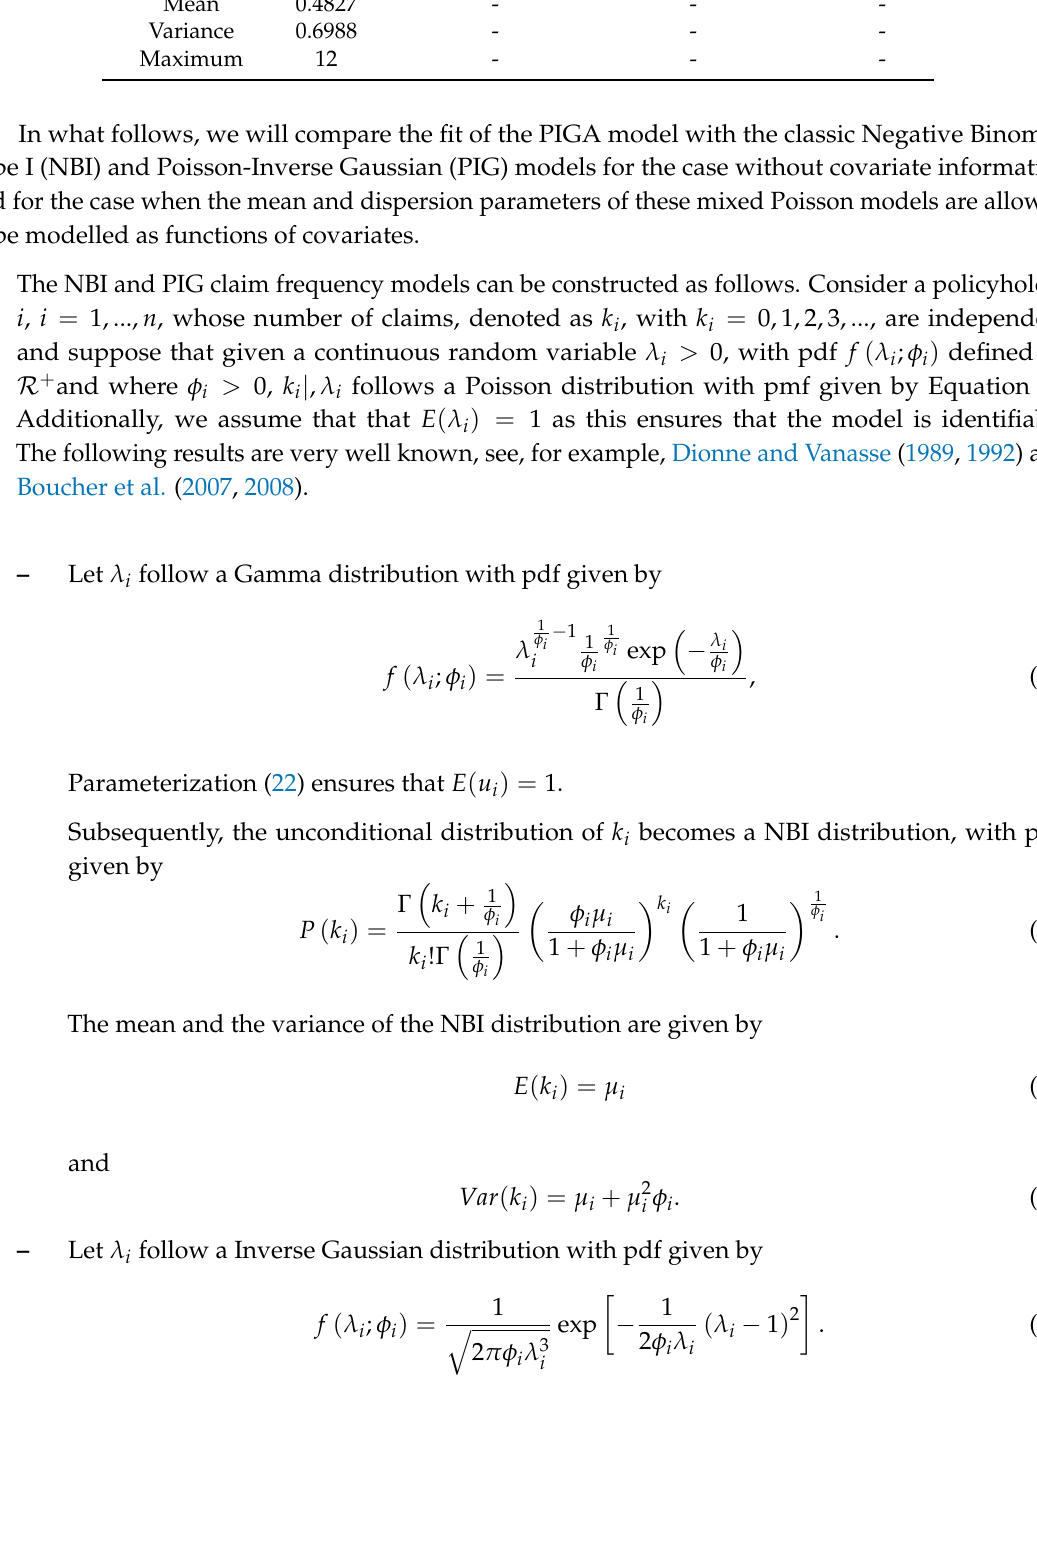
Table 1. Descriptive statistics of claim counts and the size of the different categories of the explanatory variables. Age of the Horsepower of Age of the Statistic Value Driver (AD) the Car (HP) Car (AC) # Observations 14,143 C1: 3238 C1: 5042 C1: 4318 Minimum 0 C2: